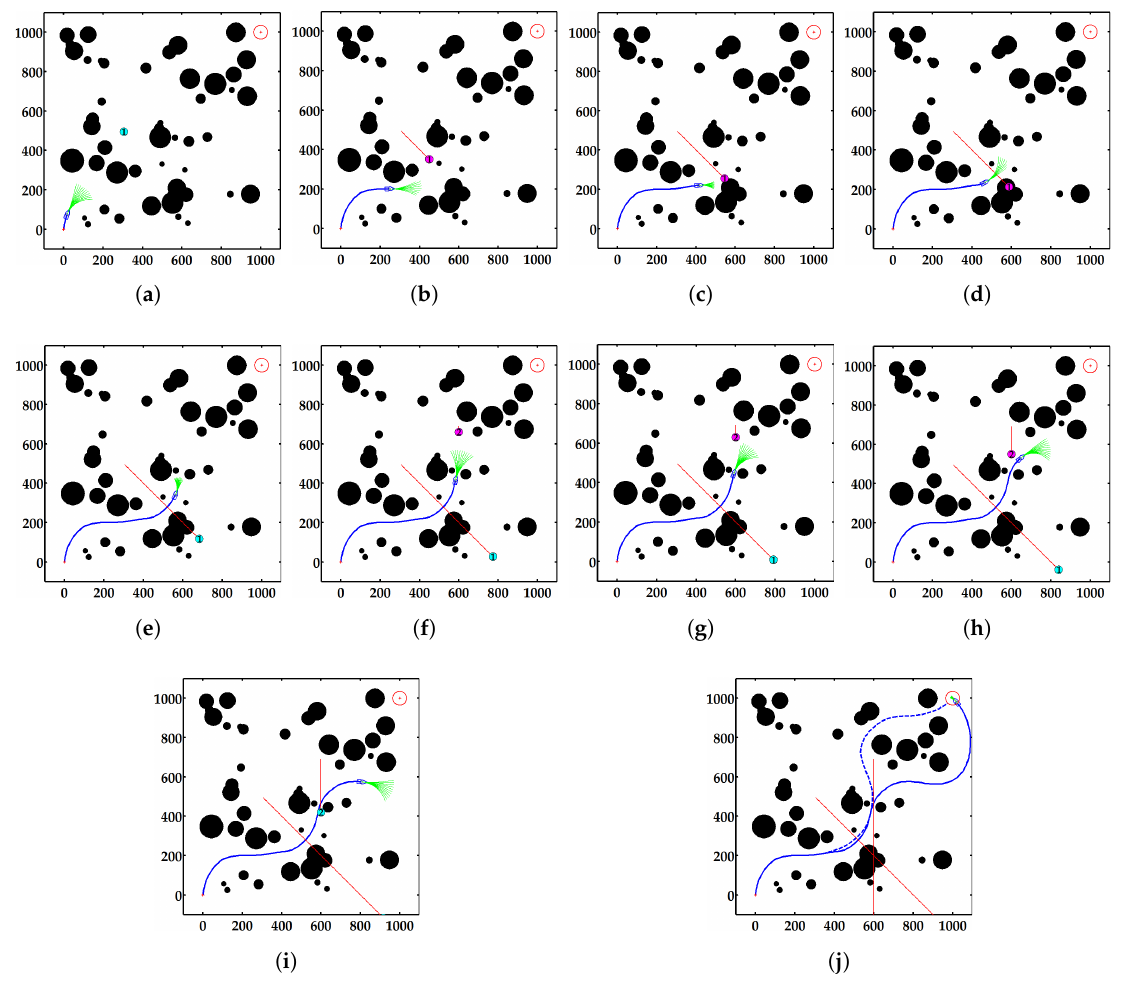
Figure 6. Demonstration diagram of the USV in the dynamic environment. ( a ) Time 15 s; ( b ) Time 39 s; ( c ) Time 55 s; ( d ) Time 62 s; ( e ) Time 78 s; ( f ) Time 93 s; ( g ) Time 96 s; ( h ) Time 104 s; ( i ) Time 117 s; ( j ) Time 174 s. Table 3. Results of the evaluation index comprised of two tests in the simulation environment.